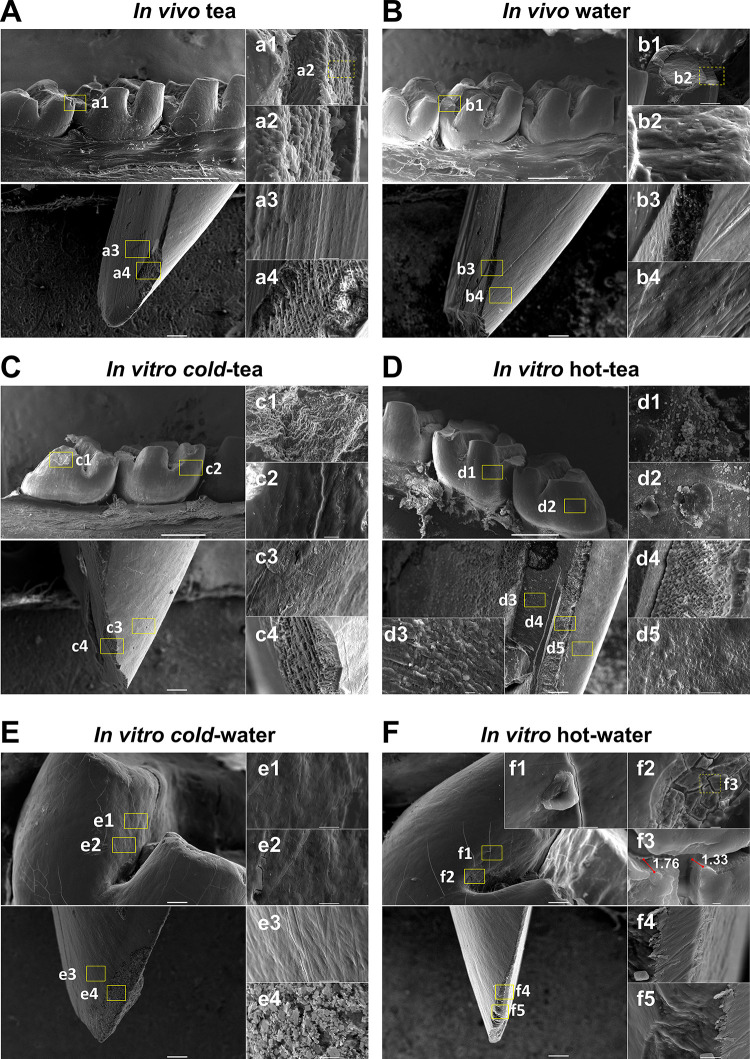
The ultrastructure of enamel is altered by tea and temperature.Molars (upper) and incisors (below) were analyzed by Scanning Electron Microscopy from in vivo (A-B) and in vitro groups (C-F). (A) For the in vivo tea group, the arrangement of enamel rods from a fracture (a1, a2) and the view of the lingual fossa of an incisor showing the normal porosity between hydroxyapatite crystals (a3) and dentinal tubules from the apposed surface (a4). (B) Molar from the in vivo water group showing the occlusal enamel composition (b1, b2). The incisor displays the enamel, dentin junction (b3) and the vestibular lobe (b4). (C) Molar from the cold-tea group showing aggregates over the enamel prisms, and an arrangement, which was not seen in the enamel rods of the incisor from the external lobe (c3) and enamel-dentin junction (c4). (D) In vitro hot-tea group showing a generalized aggregated matter deposited on the surface of the enamel on molars (d1, d2), and three regions from an incisor showing roughness of dentinal tubules with deposition of some particles (d3). Some deposition was noticeable in the dentin-enamel junction (d4). Deposition was irregularly studded in the outermost enamel of incisor in the hot-tea group (d5). (E) The molar from the cold-water group did not show abnormal roughness in the external enamel (e1, e2) or in the enamel from the incisor of the vestibular lobe (e3). Further, some crystal formation from immature enamel was identified (e4). (F) The hot-water group induced severe damage in teeth, leading to 1.3 and 1.76 μm fractures and breakages (f1, f2) in the upper enamel surface (f3) of molars, while some breaks were seen in incisors (f4, f5). The scale of Figs is represented by a grey bar 1 mm (main insert), 10 μm (sub-insert) and 1 μm (farthest bottom right panels). Different areas were randomly analyzed per molar or incisor (N = 3 jaws, N = 24 teeth per group).